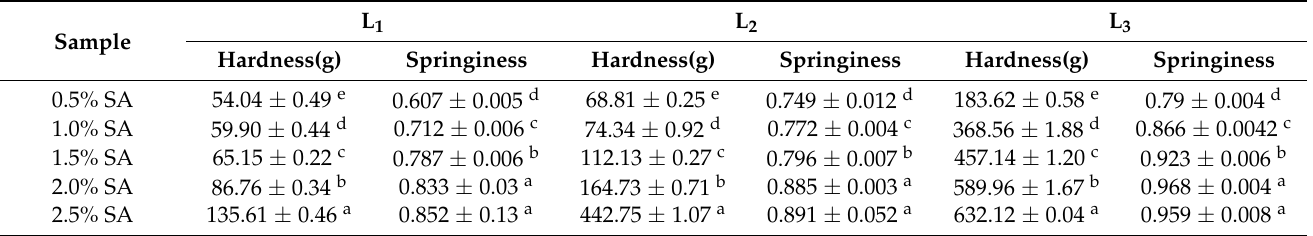
Table 1. Springiness and hardness of gel microspheres.